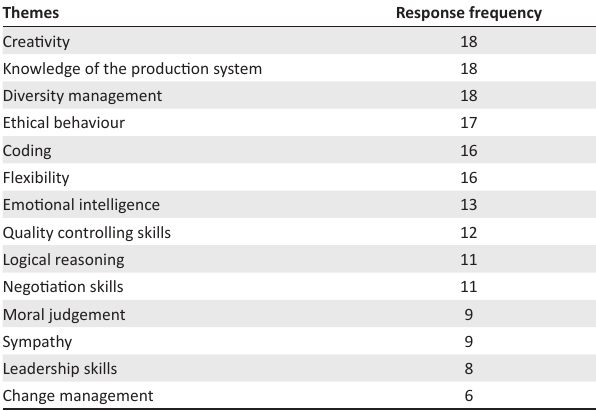
TABLE 8: Additional competencies vital in Industry